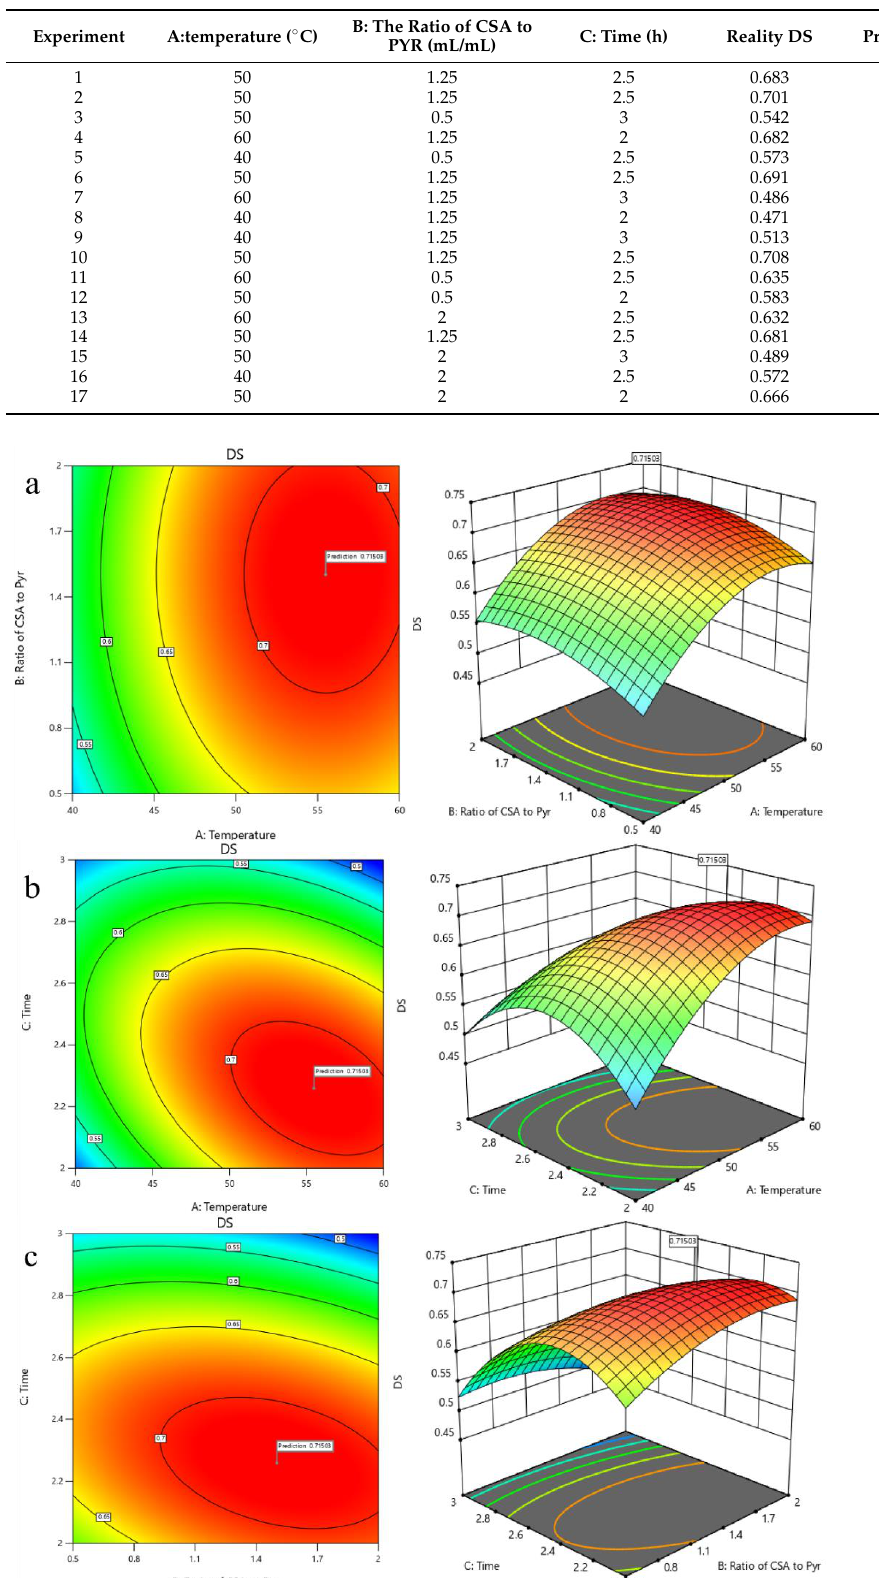
Figure 3. Tri-dimensional response surface and contour plots. ( a ) Temperature and ratio of CSA to Pyr; ( b ) temperature and time; ( c ) ratio of CSA to Pyr and time.